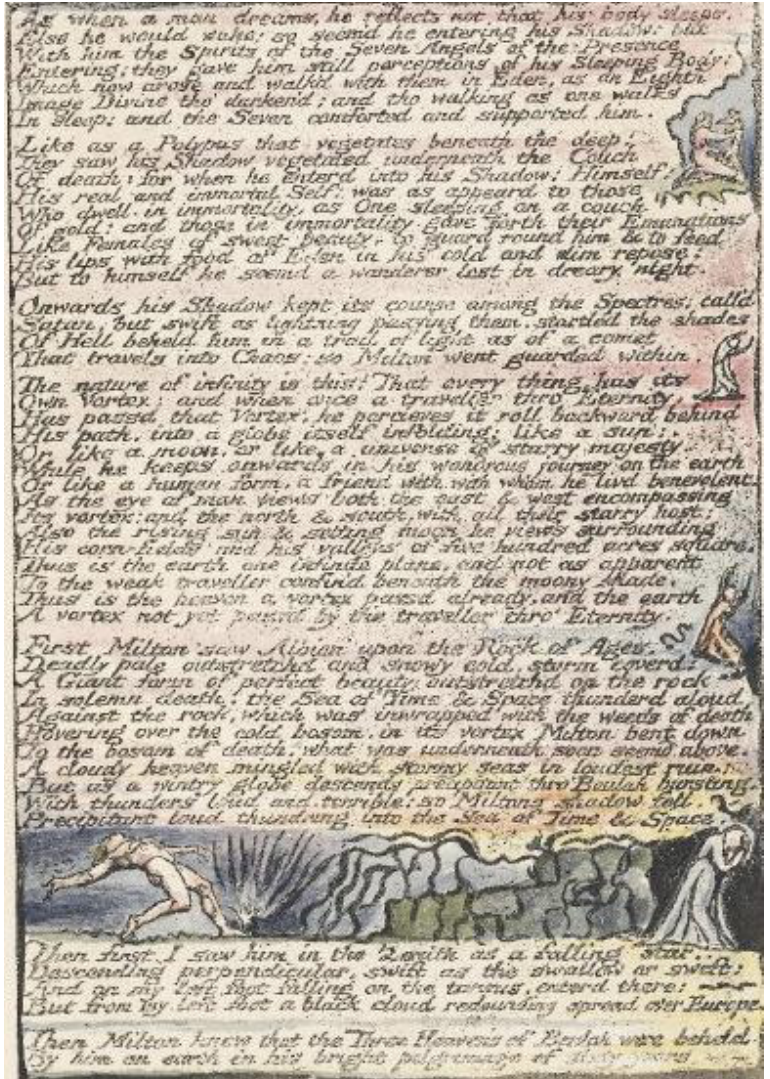
Figure 1. Milton: A Poem , Copy A, Plate 14 © The Trustees of the British Museum.